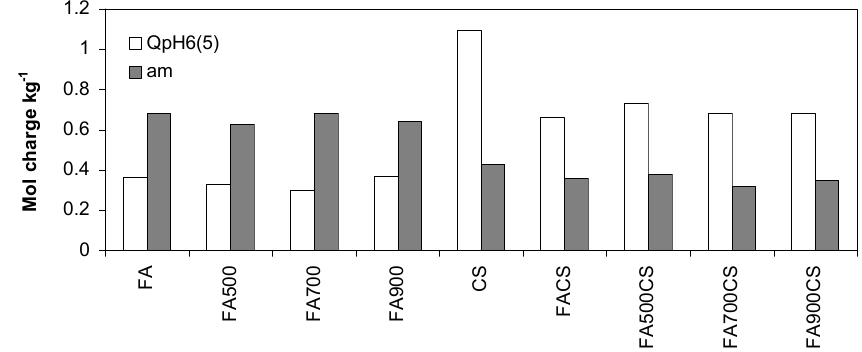
Figure 13. Comparison of surface charge measured from potentiometric titration at pH = 6 after adsorbents’ pretreatment at pH = 5 (QpH6(5)) and amount of surface charge neutralized by adsorbed As(V) anions (am).